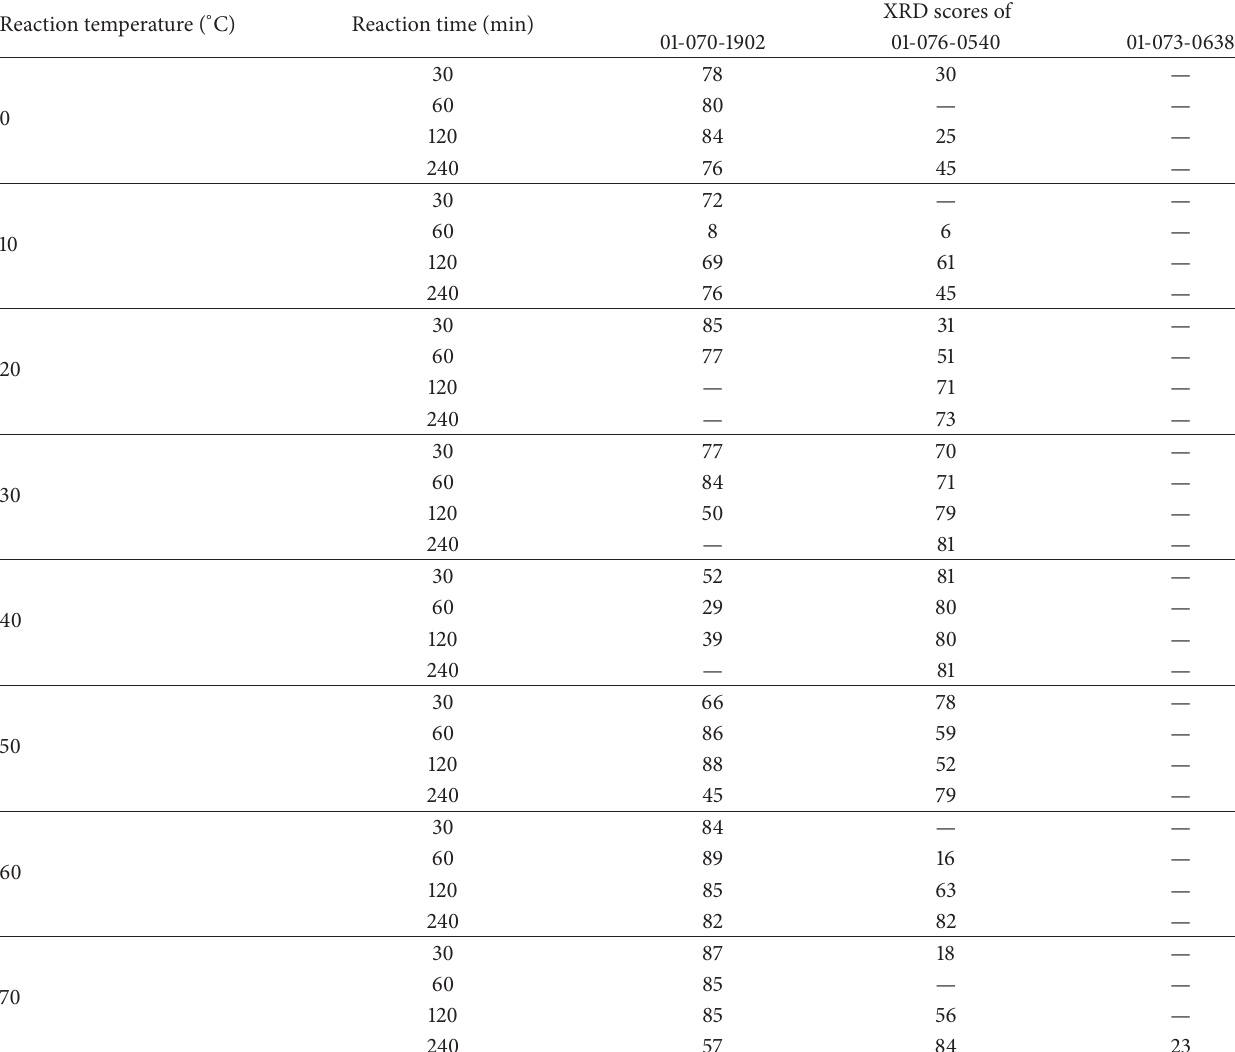
Table 1: XRD results of the synthesized magnesium borate